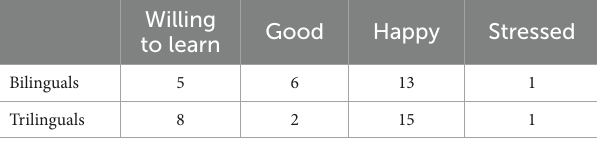
TABLE 4 Themes emerged as an answer to question 2. Willing to